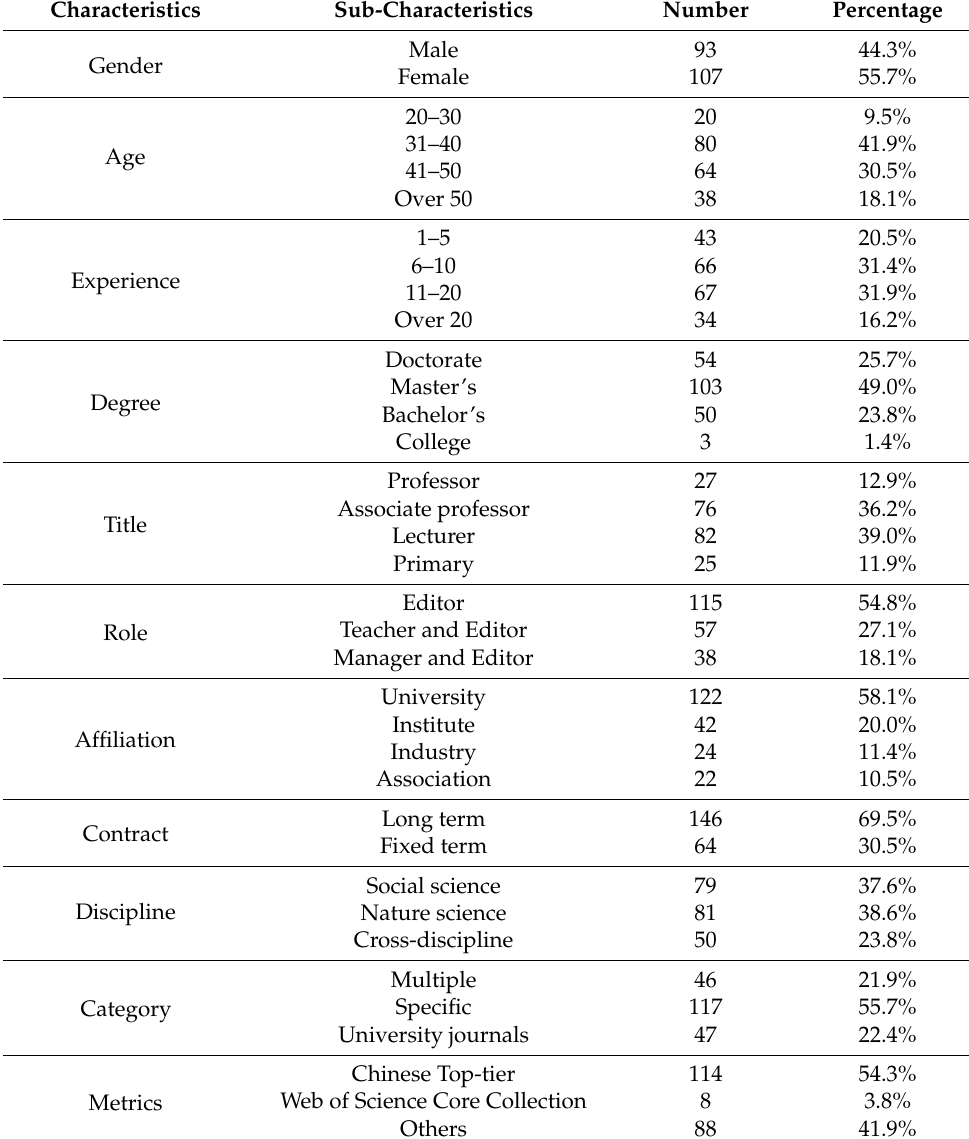
Table 1. Characteristics of study